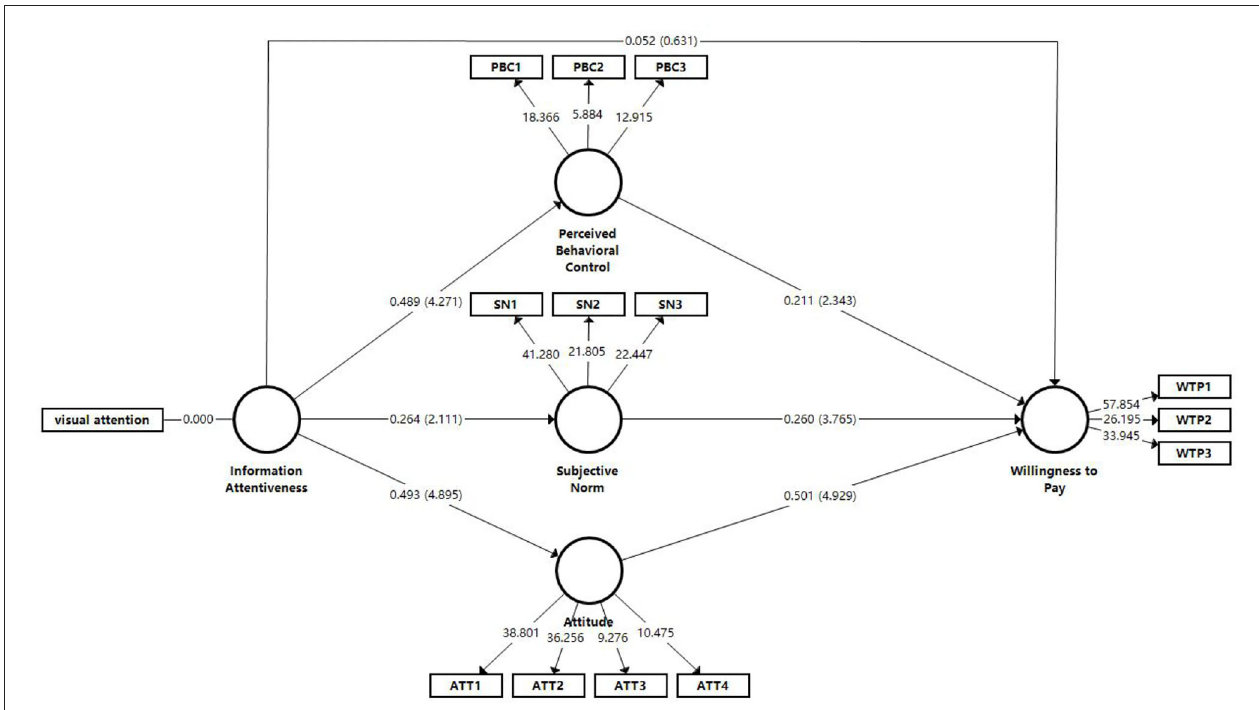
FIGURE 4 | Model path for WTP for healthy housing.